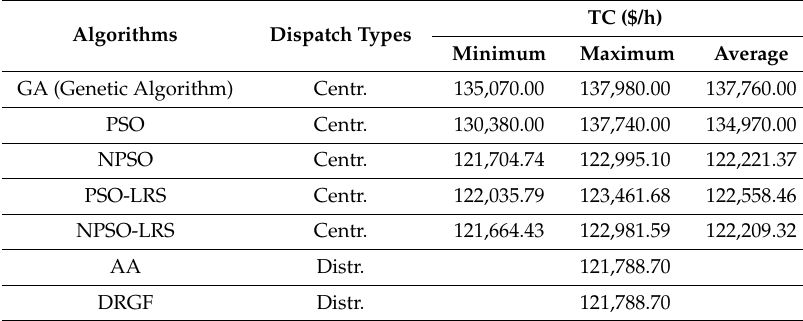
Table 4. Costs for 40 units test system from 100 trials.